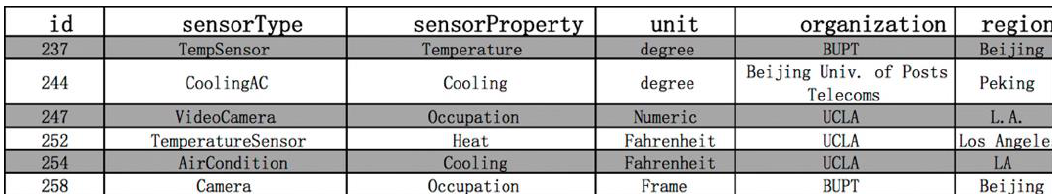
Figure 13. Parts of the EL results stored in Neo4i graph database. The blue circles represent the linked entities and types to DBpedia. It is annotated as the “linkTo” property.